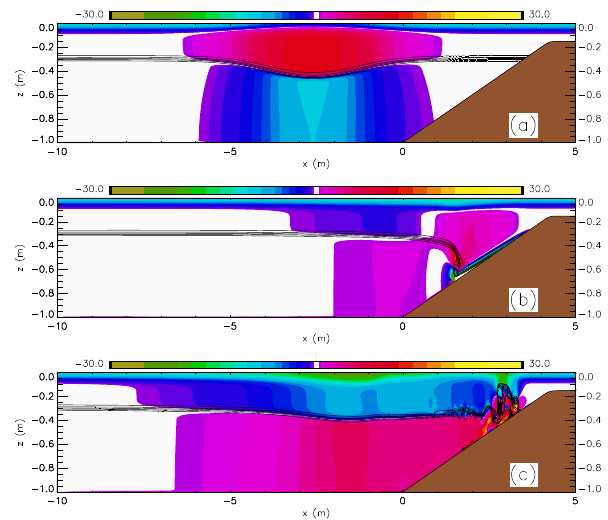
Fig. 12. Contour plots of the density field (solid lines) and hor- izontal velocity field (colours) for a shoaling ISW with the py- cnocline intersecting a sloping bottom boundary. (a) t = 25s. (b) t = 45s. (c) t = 60s. The white regions indicate regions where | u | < 0 . 0013ms − 1